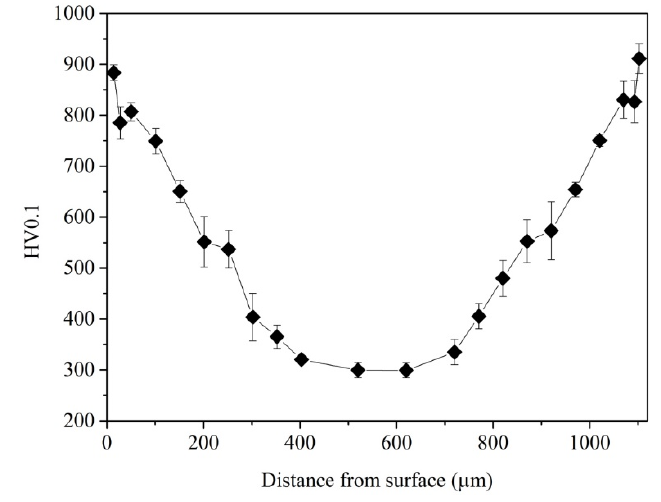
Figure 2. Variation of Vickers microhardness as a function of the distance from the surface. The hardness changed similarly along the directions from two surfaces.